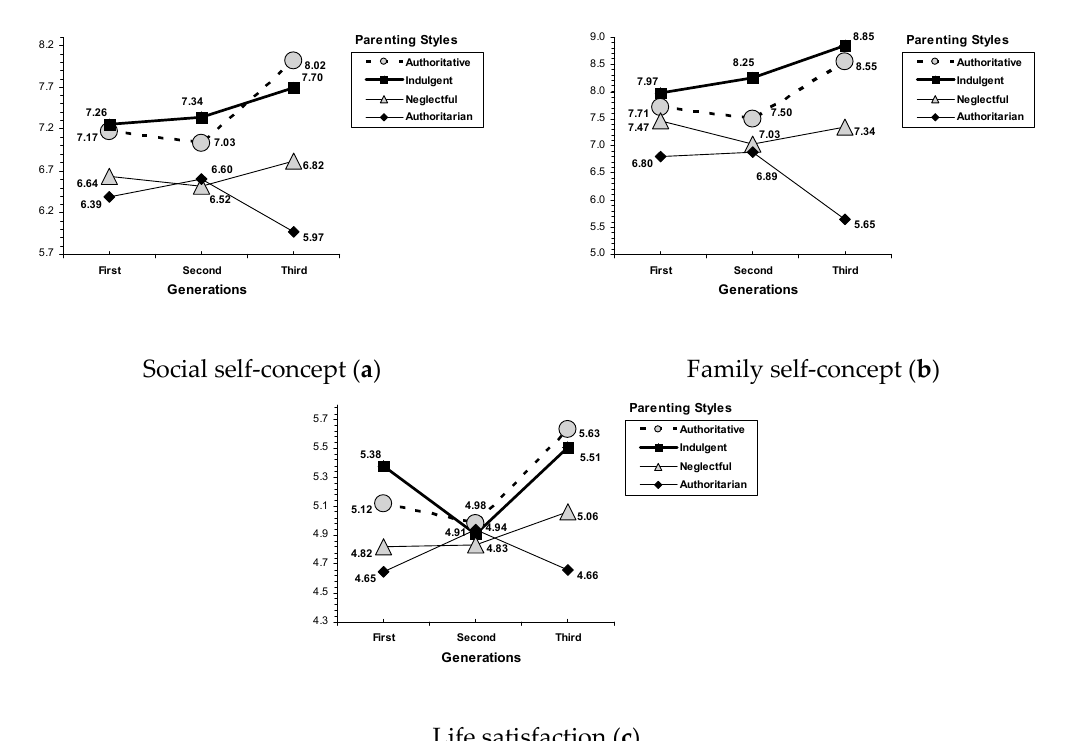
Figure 2. Interactions of parenting style by generation. ( a ) Social self-concept, ( b ) family self-concept, ( c ) life satisfaction.